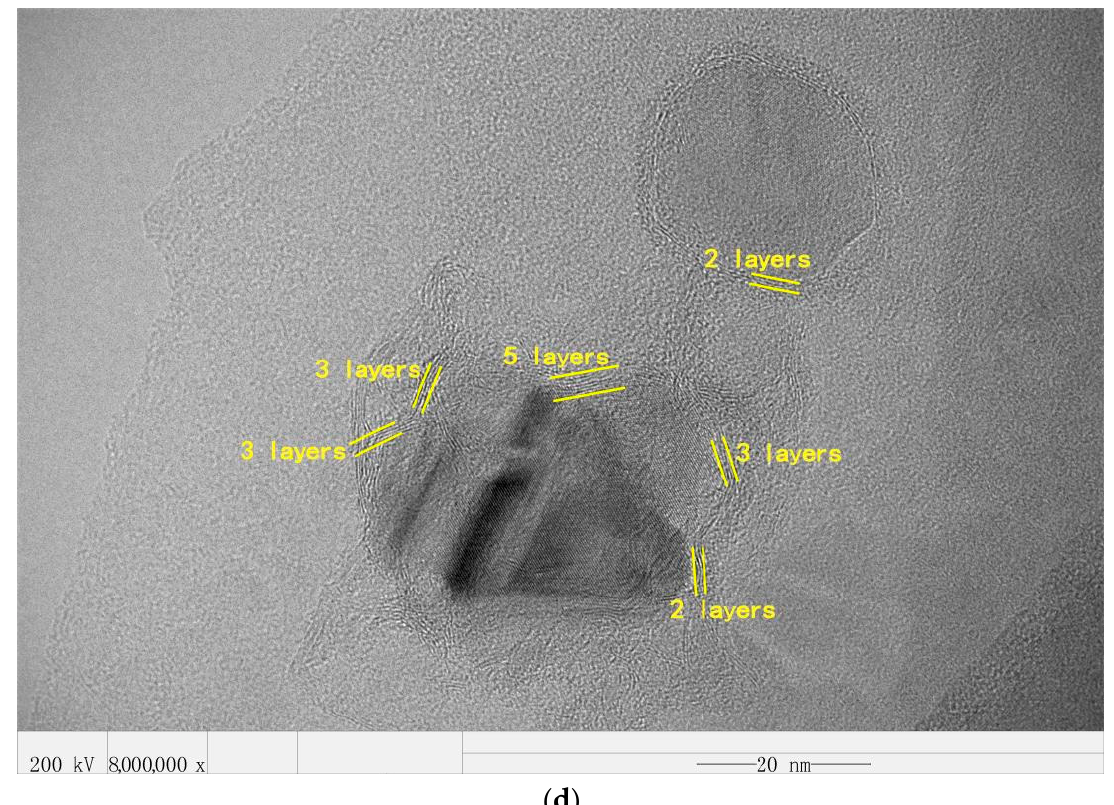
Figure 6. Structure of graphene-wrapped SiC nanoparticles randomly selected at different rotational speeds in HRTEM. ( a ) 160 rpm; ( b ) 200 rpm; ( c ) 240 rpm; ( d ) 280 rpm.